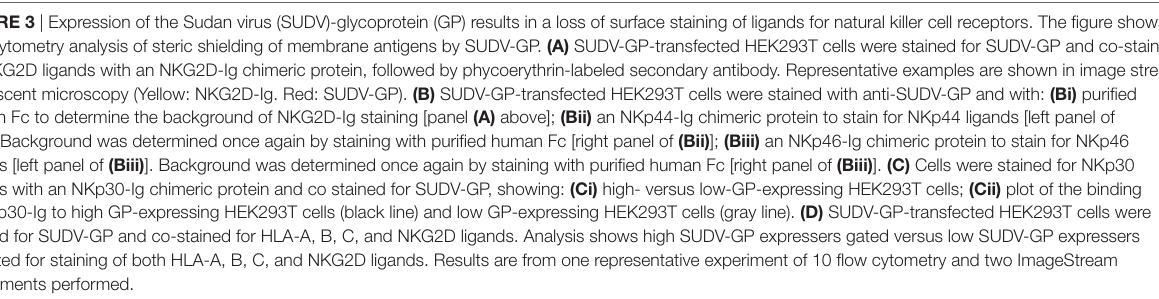
FigUre 3 | Expression of the Sudan virus (SUDV)-glycoprotein (GP) results in a loss of surface staining of ligands for natural killer cell receptors. The figure shows flow cytometry analysis of steric shielding of membrane antigens by SUDV-GP. (a) SUDV-GP-transfected HEK293T cells were stained for SUDV-GP and co-stained for NKG2D ligands with an NKG2D-Ig chimeric protein, followed by phycoerythrin-labeled secondary antibody. Representative examples are shown in image stream fluorescent microscopy (Yellow: NKG2D-Ig. Red: SUDV-GP). (B) SUDV-GP-transfected HEK293T cells were stained with anti-SUDV-GP and with: (Bi) purified human Fc to determine the background of NKG2D-Ig staining [panel (a) above]; (Bii) an NKp44-Ig chimeric protein to stain for NKp44 ligands [left panel of (Bii) ]. Background was determined once again by staining with purified human Fc [right panel of (Bii) ]; (Biii) an NKp46-Ig chimeric protein to stain for NKp46 ligands [left panel of (Biii) ]. Background was determined once again by staining with purified human Fc [right panel of (Biii) ]. (c) Cells were stained for NKp30 ligands with an NKp30-Ig chimeric protein and co stained for SUDV-GP, showing: (ci) high- versus low-GP-expressing HEK293T cells; (cii) plot of the binding of NKp30-Ig to high GP-expressing HEK293T cells (black line) and low GP-expressing HEK293T cells (gray line). (D) SUDV-GP-transfected HEK293T cells were stained for SUDV-GP and co-stained for HLA-A, B, C, and NKG2D ligands. Analysis shows high SUDV-GP expressers gated versus low SUDV-GP expressers analyzed for staining of both HLA-A, B, C, and NKG2D ligands. Results are from one representative experiment of 10 flow cytometry and two ImageStream experiments